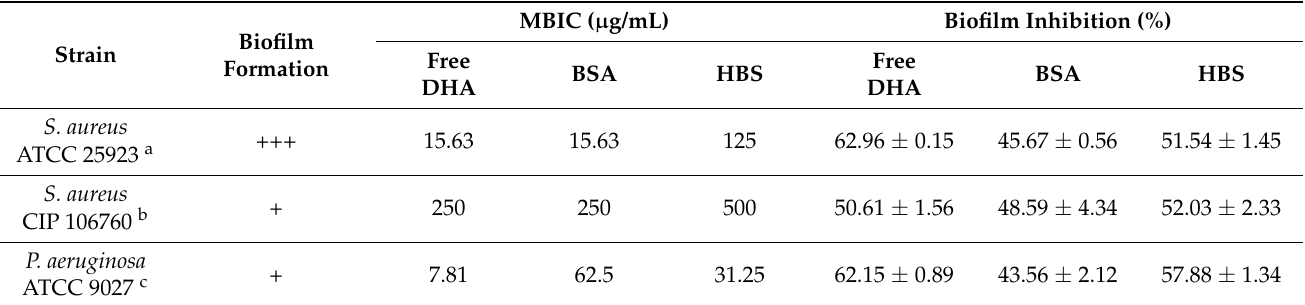
Table 4. Minimum biofilm inhibitory concentration (MBIC) values ( µ g/mL) and biofilm inhibition (BI) percentage of DHA against Gram-positive ( S. aureus ATCC 25923 and S. aureus CIP 106760) and Gram-negative ( P. aeruginosa ATCC 9027) with the Bioburden challenge. Results showed as mean ± SD, p <